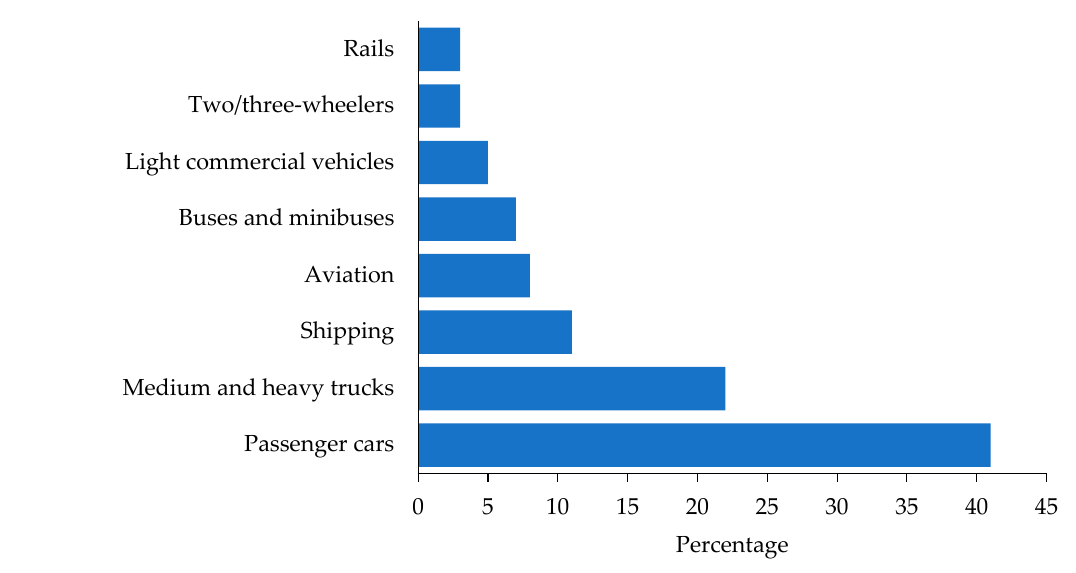
Figure 1. Transportation carbon emissions by sub-sectors. Data from [35,36].